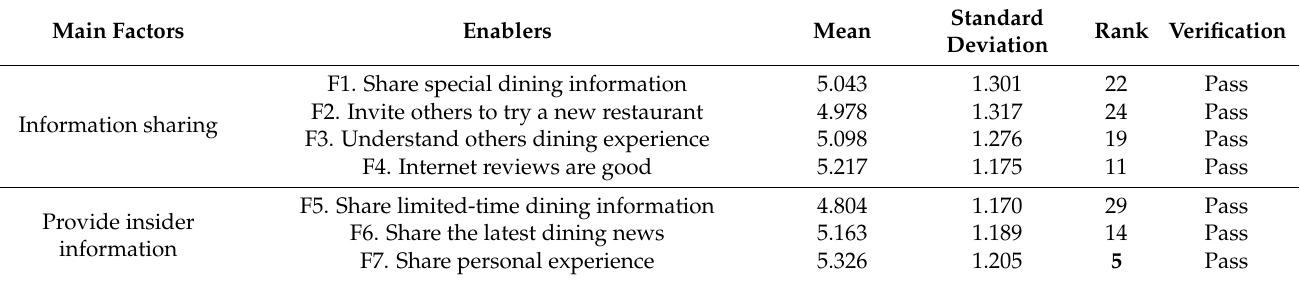
Table 2. Scores and ranking of the